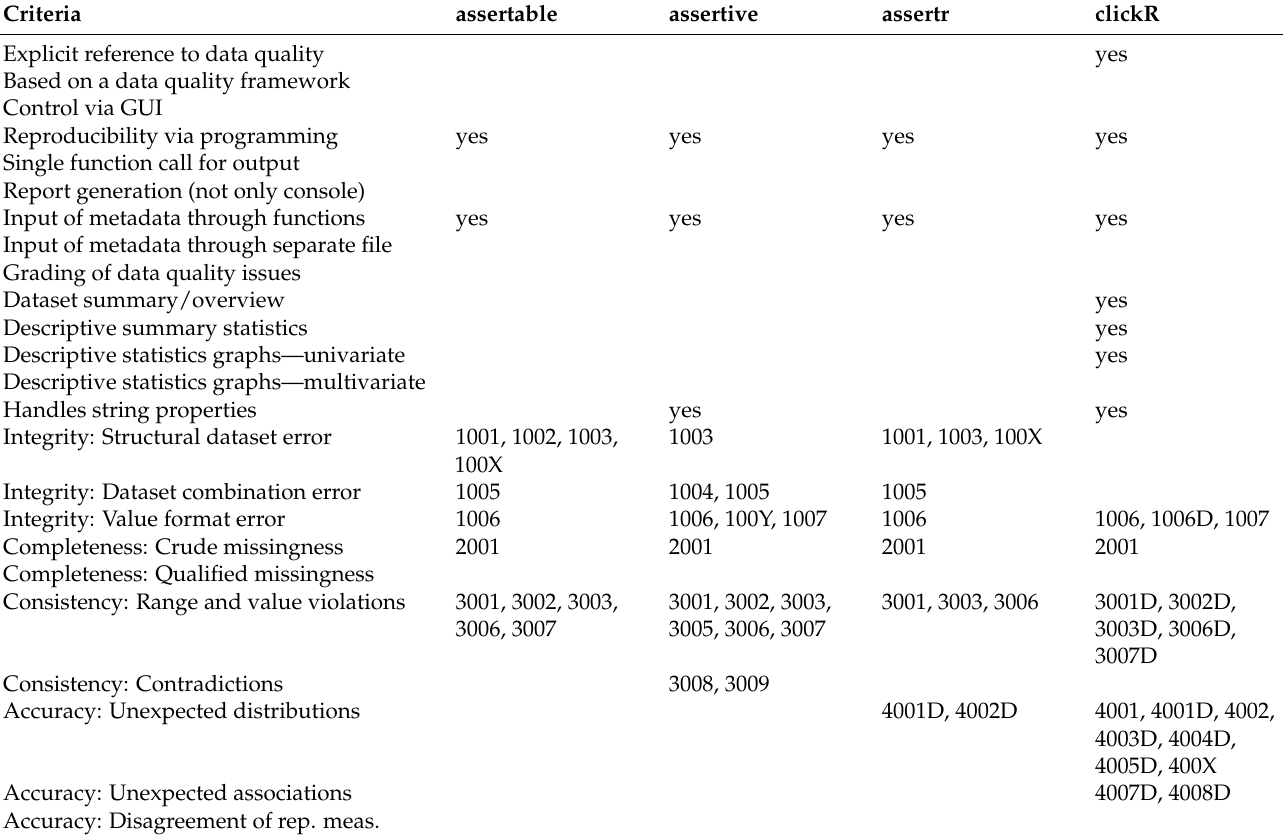
Table A1. Data quality assessment capabilities by